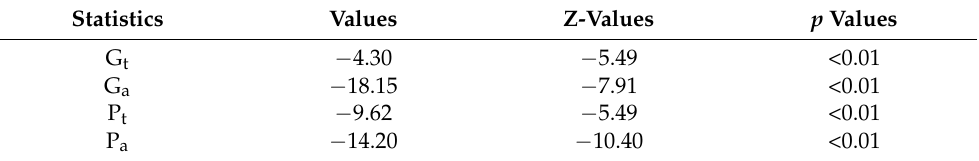
Table 6. Westerlund second-generation error correction panel cointegration test.